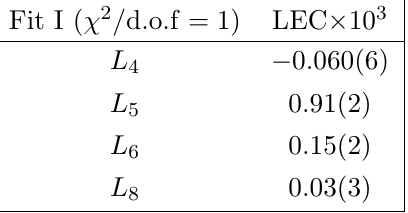
Table 1 . Values of the LECs obtained in Fit I.